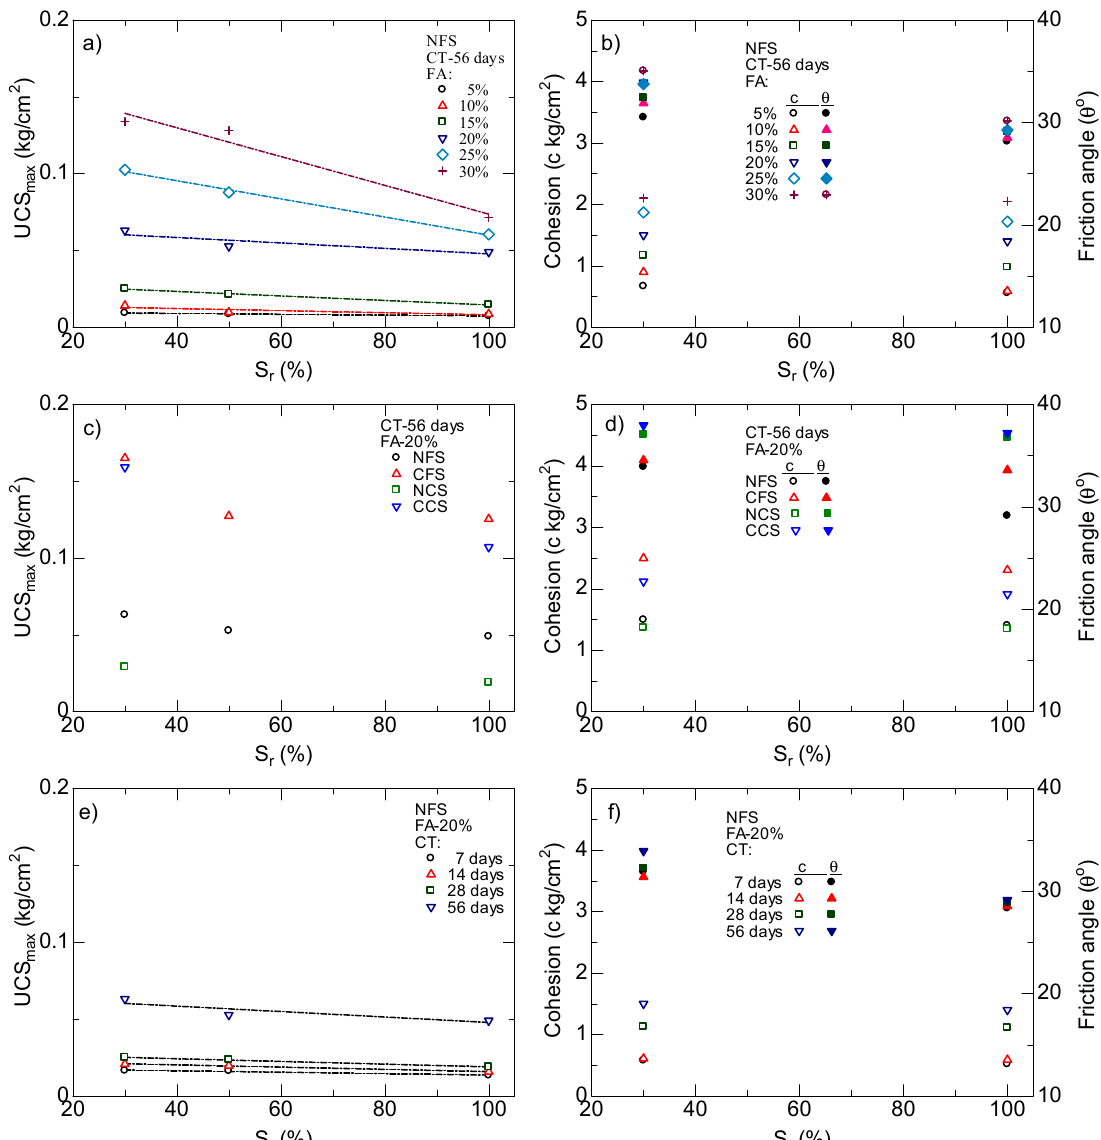
Figure 6. The effect of the degree of saturation on the mechanical properties of fly-ash-stabilized sand. ( a ) UCS max -S r relationship of NFS at various FA with CT-56 days, ( b ) shear strength parameters-S r relationship of NFS at different FA with CT-56 days, ( c ) UCS max -S r relationship of dissimilar sands with CT-56 days and 20% FA, ( d ) shear strength parameters-S r relationship of diverse sands with CT-56 days and 20% FA, ( e ) UCS max -S r relationship of NFS at various CT with 20% FA, ( f ) shear strength parameters- S r relationship of NFS at any kinds of CT with 20% FA.